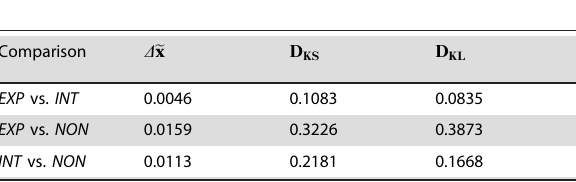
Table 1. Measures comparing cumulative distributions of distance to nearest neighbor d in experiment ( EXP ), a social interaction model ( INT ) and a noninteracting control model ( NON